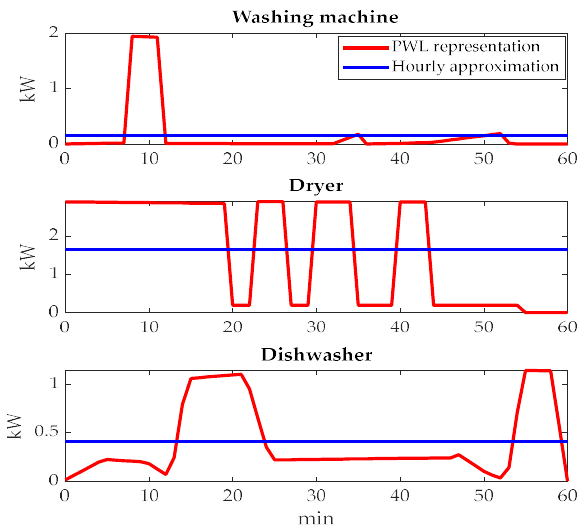
Figure 31. Load-profile representations considered for simulation.